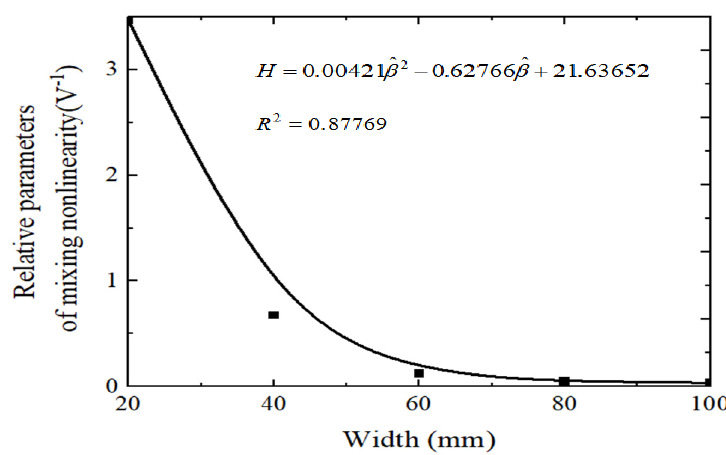
Figure 19. Variation of mixed frequency factor with crack width.